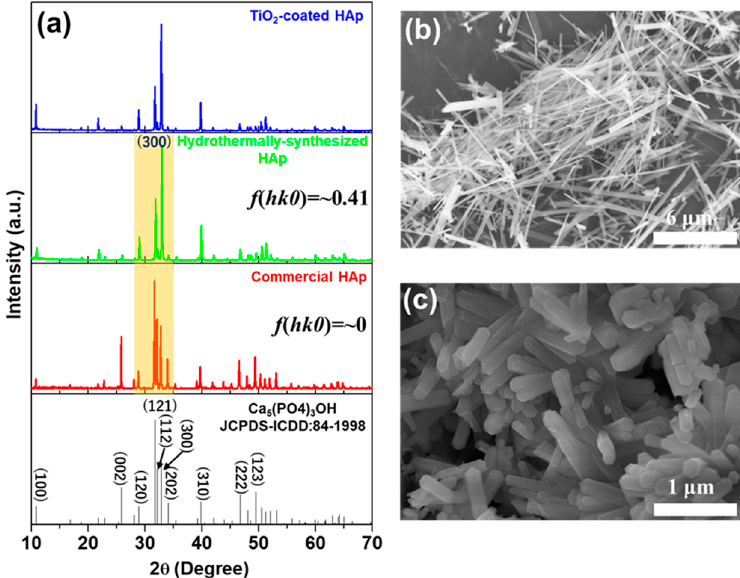
Figure 2. ( a ) XRD patterns of the commercial, hydrothermally-synthesized, and TiO 2 -coated HAp powders, denoting the calculated Lotgering factors of f ( hk0 ); and FE-SEM images of unique morphologies in ( b ) the hydrothermally-synthesized whisker-like and ( c ) commercial rod-like HAp particles.